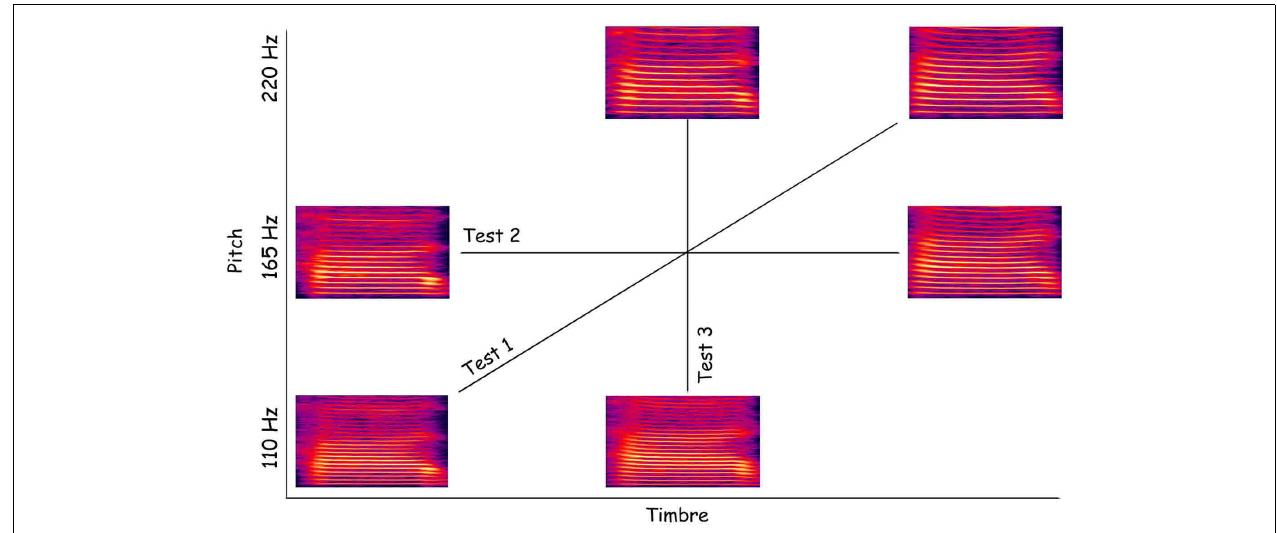
FIGURE 1 | Spectrogram representation of the morphed voices. In the diagonal are represented the original male (lower left) and female (upper right) stimuli. From these stimuli a continuum of nine male/female voices were generated. Similar continua were created along the pitch and timbre